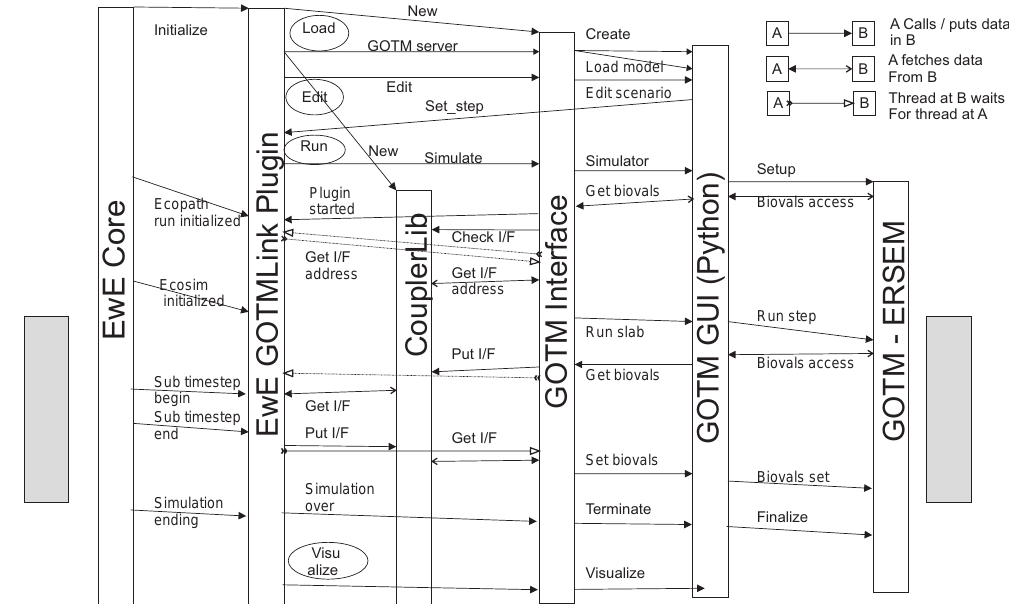
Figure 2. Sequence of operations when GOTM–ERSEM is linked with Ecopath with Ecosim (EwE) in managed model. Grey box is part of model that is run repeatedly on a daily time